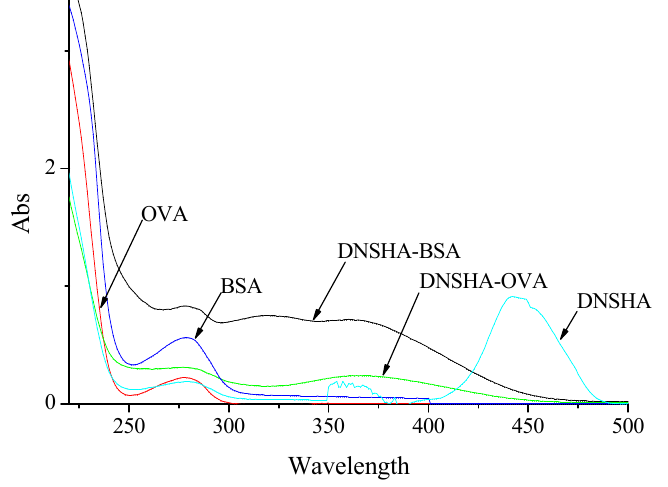
Figure 3. UV spectra of BSA, OVA, DNSHA-BSA, DNSHA-OVA and DNSHA.